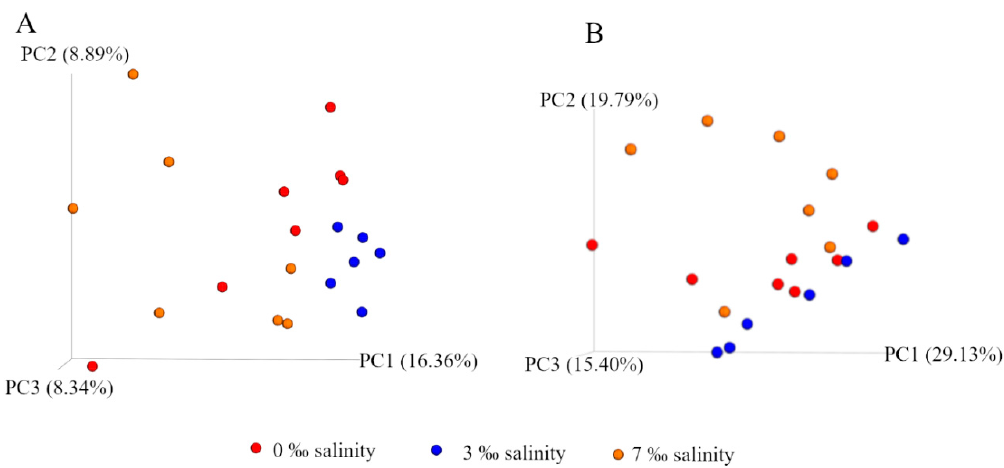
Figure 6. Beta diversity metrics. Principal coordinates analysis (PCoA) of unweighted ( A ) and weighted ( B ) Unifrac distances of gut microbial communities associated with different salinity levels. The figures show plots of individual fish according to their microbial profile.